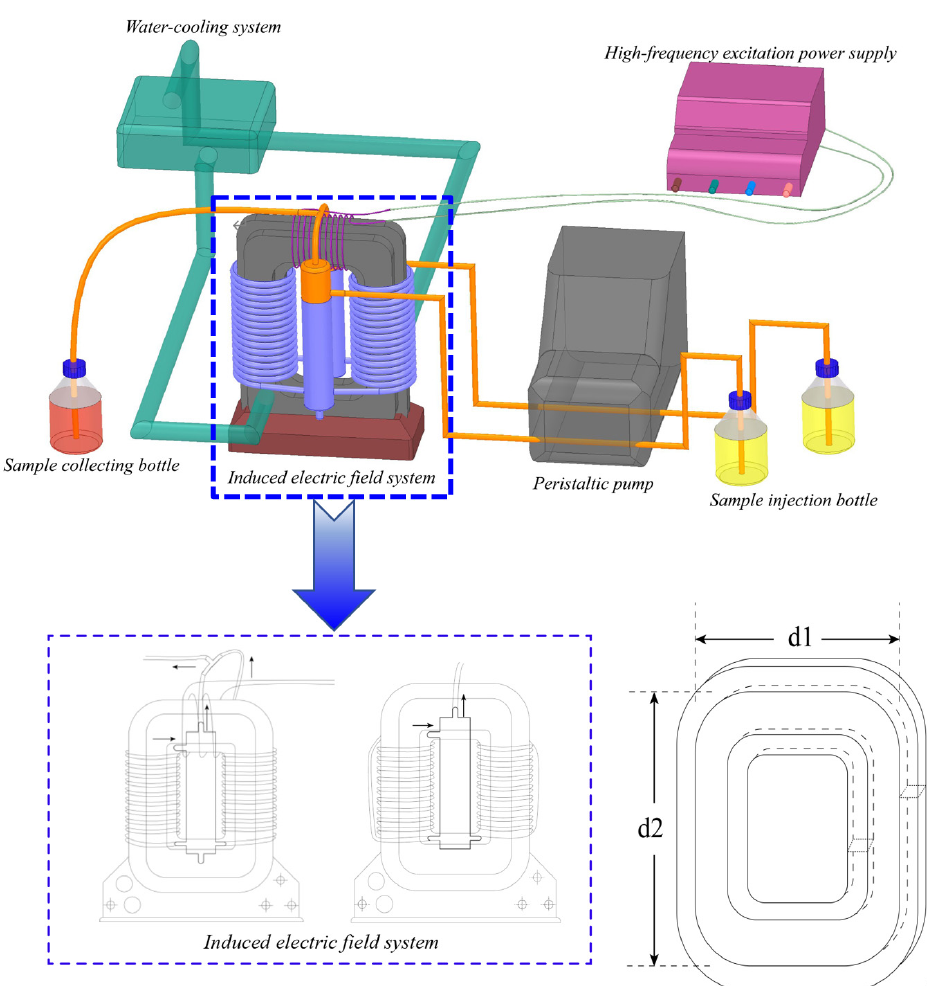
Figure 3. The schematic diagram and flow chart of the induced electric field heating unit (d1 = 15 cm, d2 = 25 cm).